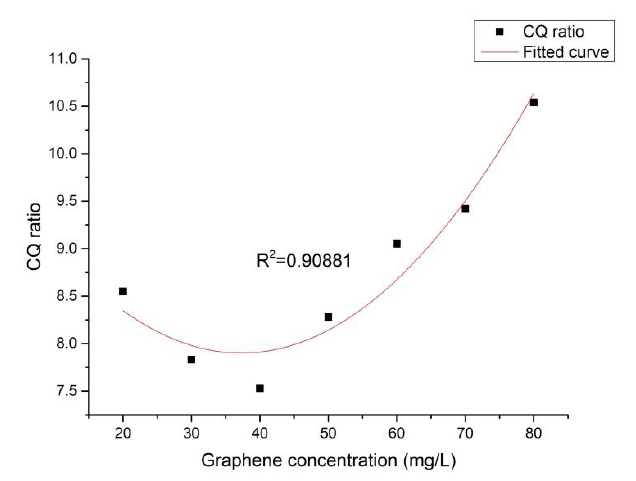
Figure 8. E ff ect of the graphene concentration on the CQ ratio. Figure 8. Effect of the graphene concentration on the CQ ratio. Figure 8. Effect of the graphene concentration on the CQ ratio.